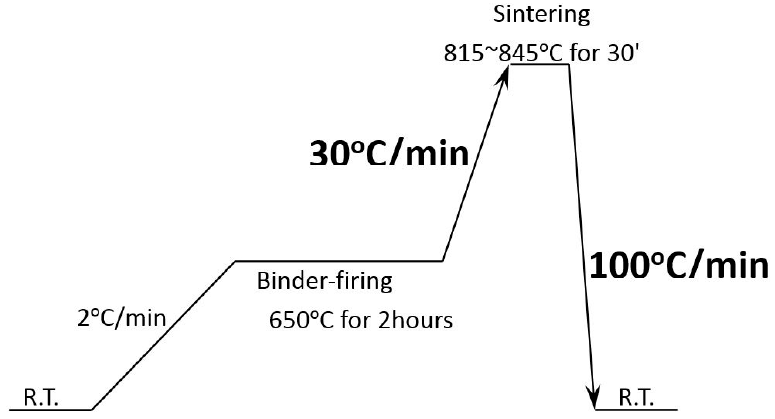
Figure 1. Schematic illustration of the sintering process.